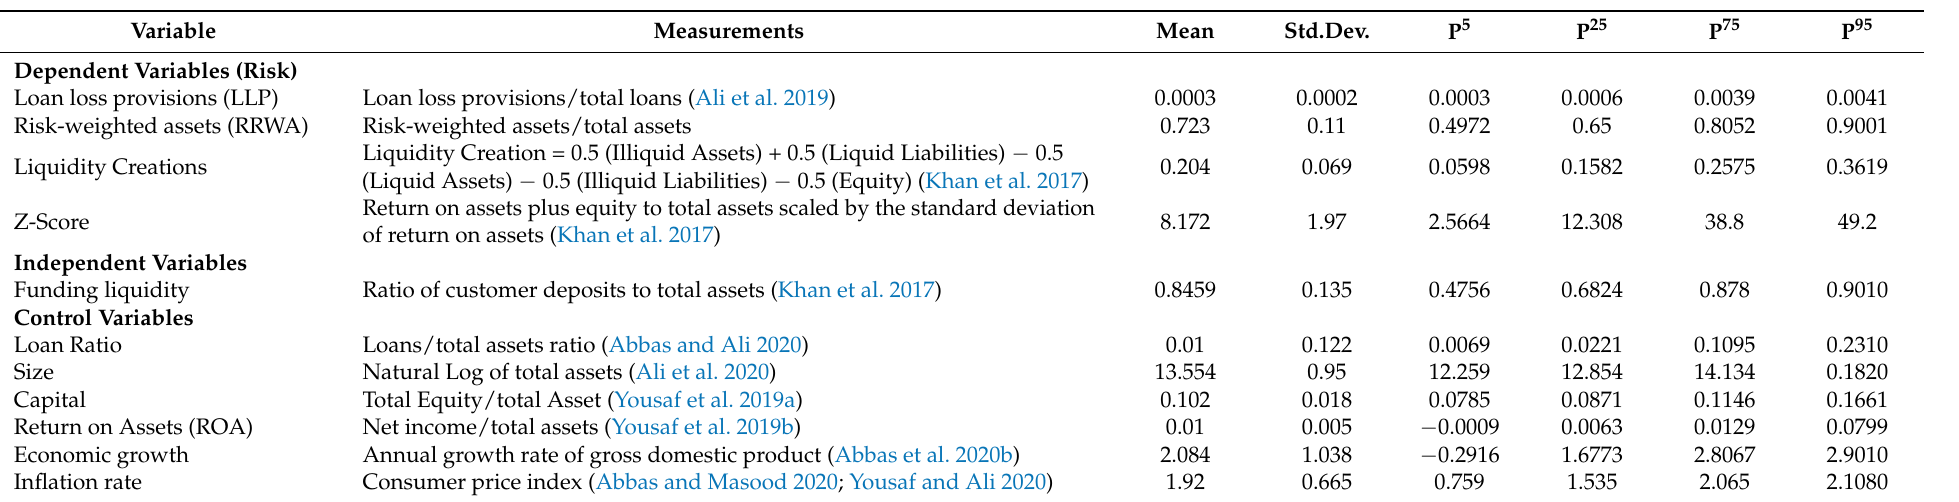
Table 1. Variable measurement and descriptive